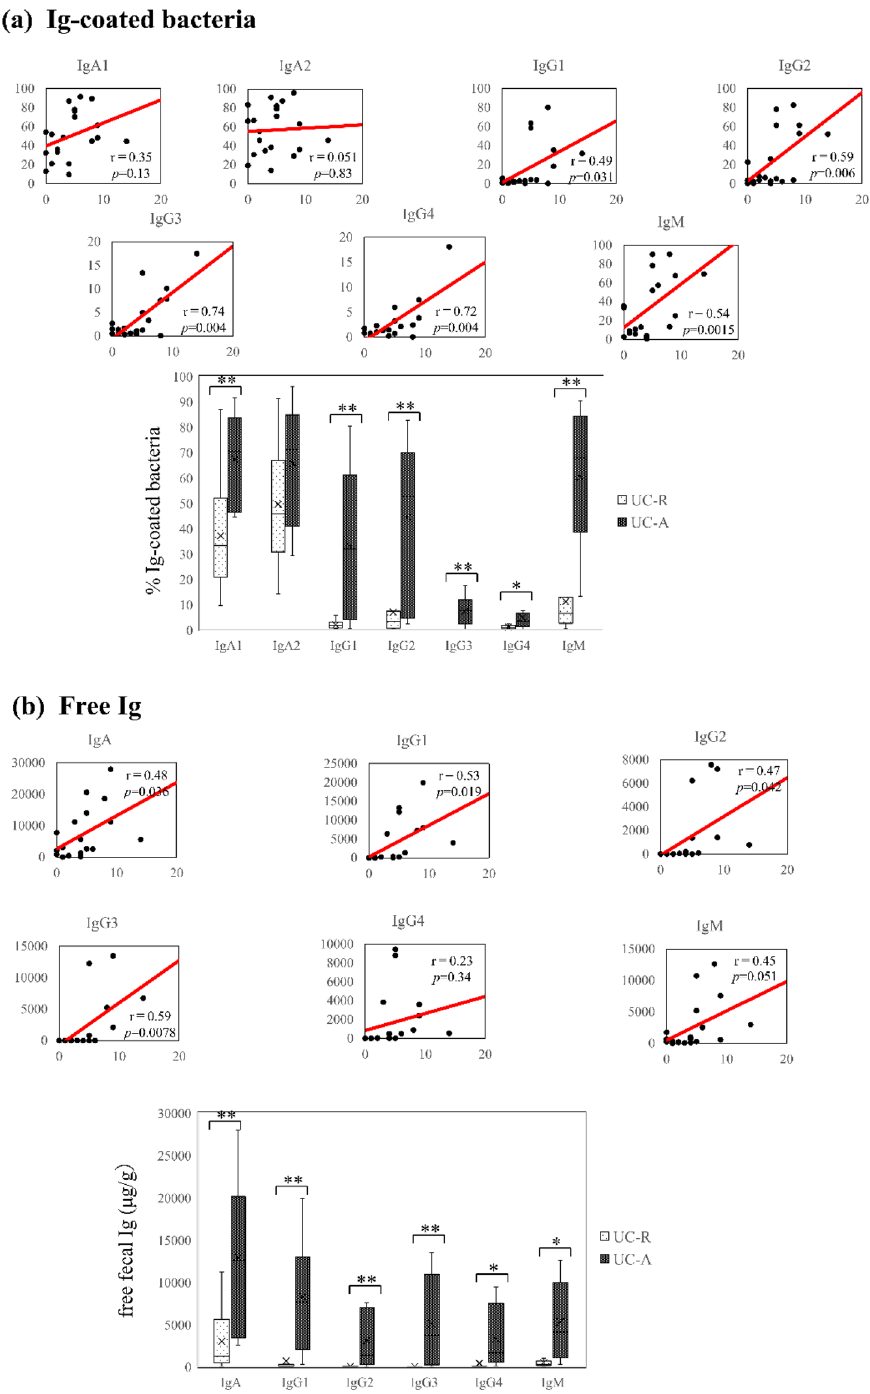
Figure 2. Correlation between UC activity as well as Ig-coated bacteria and fecal free Ig concentration. ( a ) The correlation between the ratio of each Ig-coated bacteria and the CAI score is shown in the graph. The CAI score was obtained at the time of fecal sample collection (n = 20). ( b ) Box plot showing the flow cytometry analysis results for the ratio of each Ig-coated bacteria in the UC-A (n = 9) and UC-R (n = 11) samples. UC-A had a more significant correlation with the ratio of each Ig-coated bacteria than UC-R. Disease activity was defined based on CAI. ( c ) The correlation between the concentration of fecal free Ig and the CAI score is shown in the graph. ( d ) Box plot showing the concentration of fecal free Ig in the UC-A (n = 8) and UC-R (n = 11) samples. UC-A was more correlated with the concentration of each fecal free Ig than UC-R. Spearman’s correlation analysis was performed, and the straight line in graphs ( a ) and ( c ) showed the regression line. The brackets in graphs ( b ) and ( d ) indicate significant differences. Wilcoxon rank-sum test, p -values are shown * < 0.05, **< 0.005. Student’s t -test. p -values are shown † < 0.05, †† < 0.005). UC Ulcerative colitis, CAI Clinical Activity Index, UC-A ulcerative colitis in the active phase, UC-R ulcerative colitis in the active